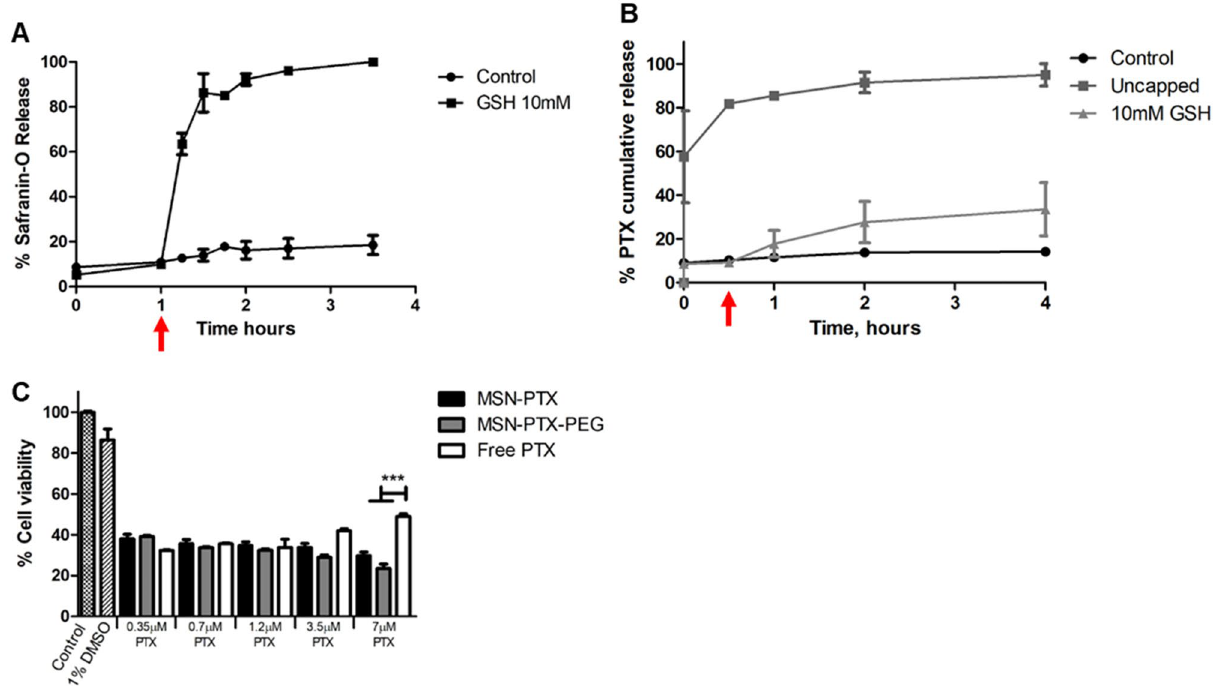
Figure 6. The successful formation of the responsive gate was confirmed by the release assays. Release from MSN-PEG was triggered after the addition of GSH as a reductive stimulus. ( A ) Safranin-O release profile. ( B ) PTX release profile. The results, presented as mean ± SEM of at least 2 independent measurements, were normalized for the highest amount released in the assay. Red arrows indicate the time of 10 mM GSH addition on the triggered release group (at 1 h for Safranin-O and at 30 min for PTX release assays). ( C ) Comparison of U-87 cell viability upon treatment with free PTX, MSN-PTX and MSN-PTX-PEG with equivalent drug concentrations. PTX was solubilized in DMSO and the same proportion (1%) of this diluent was added in all treatments. Statistical analysis: Tukey’s post-test comparing all treatments at equivalent drug concentration. P < 0.001